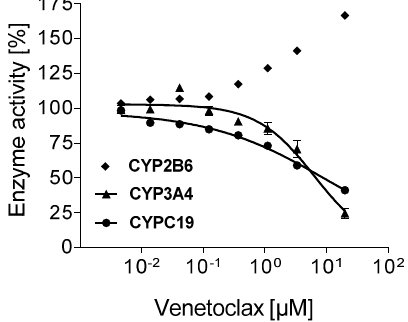
Figure 1. Inhibition of CYPs. Concentration-dependent effect of venetoclax (0.01–20 µM) on the enzyme activity of CYP2B6, CYP2C19, and CYP3A4. Data are expressed as mean ± SEM for n = 3 biological replicates measured in duplicate. CYPs with no inhibition (CYP1A2, CYP2D6) are not depicted.